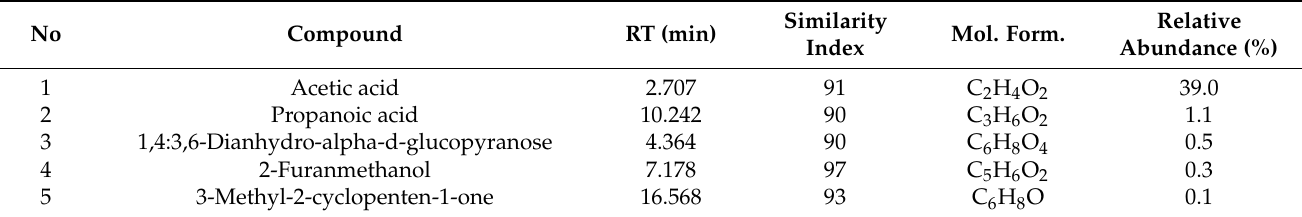
Table 7. Chemical composition of distillates of hemp leaves (LV2T) from pyrolysis stage (PS) condensed at 70 ◦ C and analyzed by